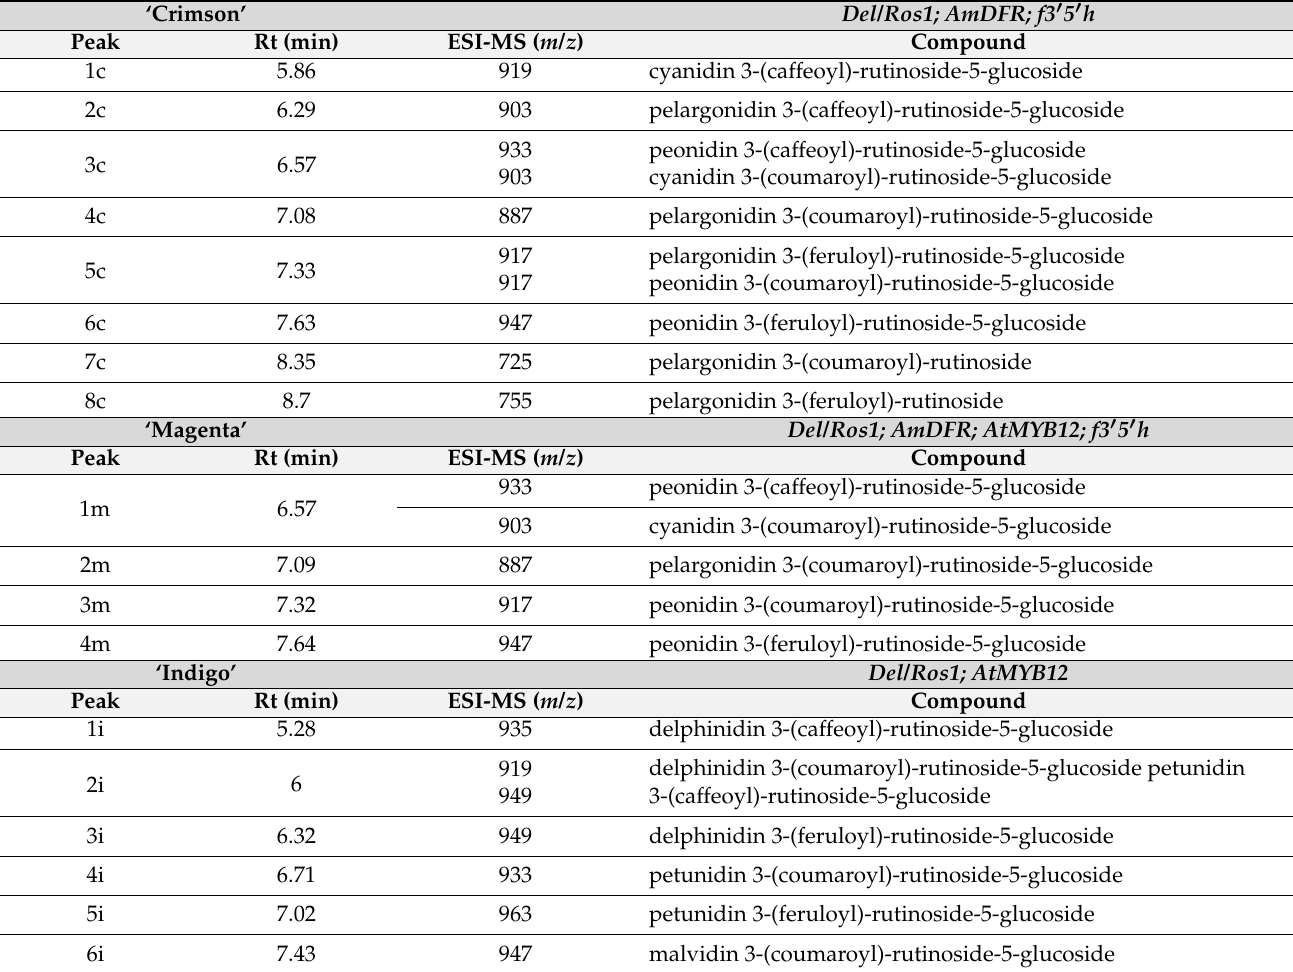
Table 1. Identification of the major anthocyanins in juice extracted from ‘Crimson’, ‘Magenta’ and ‘Indigo’ tomato fruit. Peak numbers correspond to those indicated in Figure 3. ESI-MS: electro spray ionization mass spectra; m / z : molecular mass of the